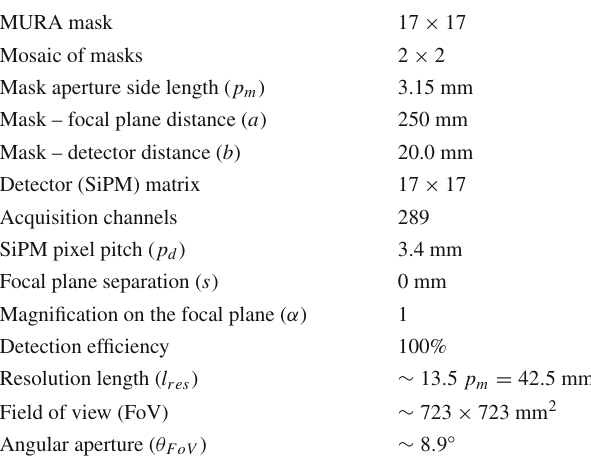
Table 1 Features of a single device (mask-mosaic and detector) MURA mask 17 ×